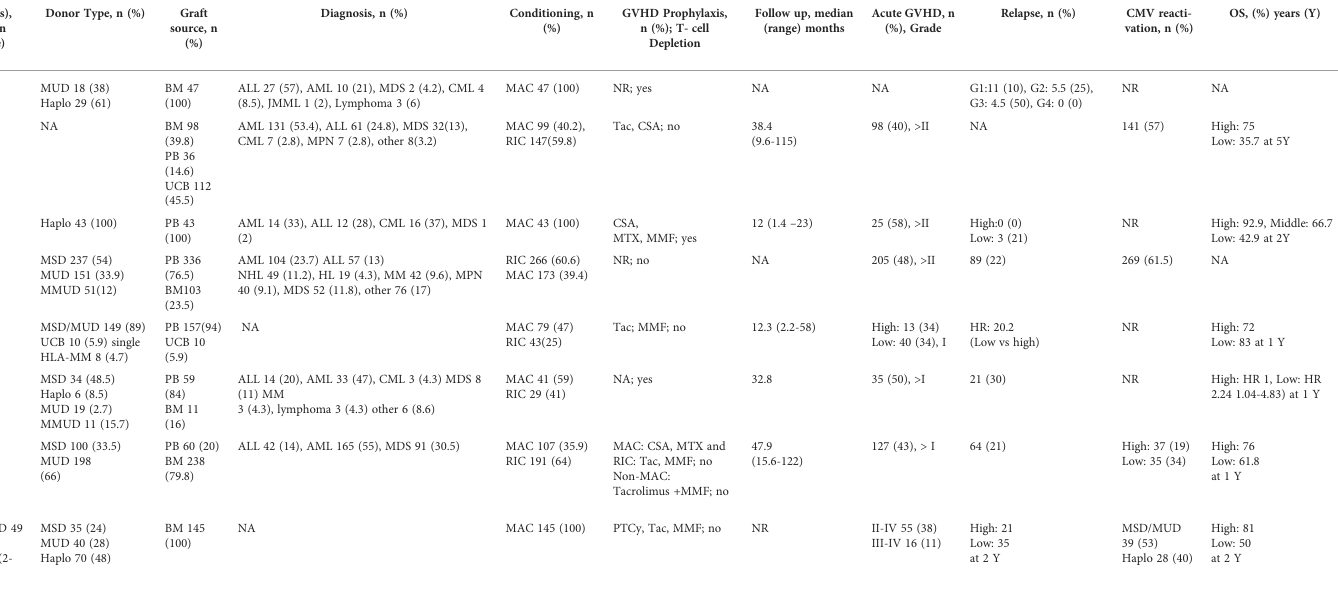
a Groups were divided based on the patterns of NK activity. Group 1 (consistently low activity <10% speci fi c lysis), group 2 (consistently high activity >30% speci fi c lysis), group 3 (initially high activity then decreasing), group 4 (initially low activity, then increasing to normal levels). b Not mentioned. c High (>9.27 cells/ m L, n=14), Middle (3.59 to 9.27 cells/ m L, n=51), Low (<3.59 cells/ m L, n=14). d ANK levels were designated from the cluster analysis and counts greater than 18.2 cells/mm3 at 60 days were considered in the high level (n=84) and counts less than this value was considered in the low level (n=38). e Cut-off values were different for 30 days vs 90 days post-transplant. For 30 days post-transplant the cut-off was <177.5/ m L. For 90 days post-transplant cut-off was <181.9 cells/ m L. OS was HR=1 at High NK and HR=2.64(0.76-9.21) at Low NK. f High: NK30>150, Low: NK30<150. g High NK cell count: >50.5 cells/mL and Low NK cell count: £50.5 cells/mL OS, overall survival; NA, not available; ALL, acute lymphoid leukemia; AML, acute myeloid leukemia; BM, bone marrow; UCB, umbilical cord blood; CLL, chronic lymphoid leukemia; HL, Hodgkin lymphoma; JMML, juvenile myelomonocytic leukemia; MAC, myeloablative conditioning; MDS, myelodysplastic syndrome; MUD, matched unrelated donor; MSD, matched sibling donor; Haplo-haploidentical donor; MMUD, mismatched unrelated donor; MM, multiple myeloma; NHL, non-Hodgkin lymphoma; NR, nonreported; PB, peripheral blood; RIC, reduced intensity conditioning; SAA, severe aplastic anemia; MPN, myeloproliferative neoplasm; TBI, total body irradiation; TCD, T-cell depleted; HR, hazard ratio; NMA, nonmyeloablative; AA, aplastic anemia; CSA, cyclosporin; Tac, tacrolimus; MMF, mycophenolate; MTX, methotrexate; PTCy, post-transplant